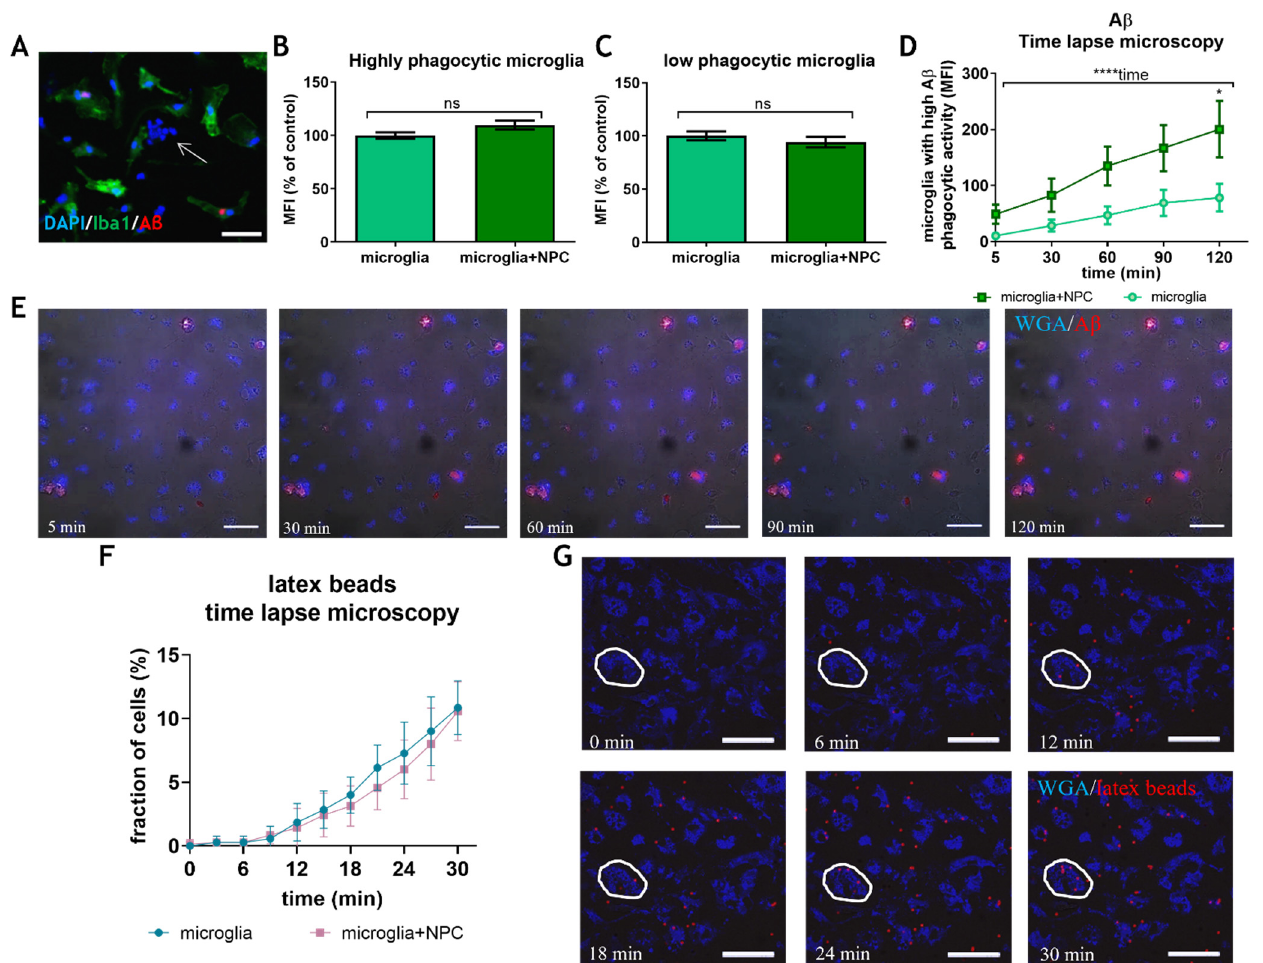
Figure 3. Time-lapse microscopy measuring the effect of newborn NPCs on microglial A β and latex beads’ uptake. ( A ) Fluorescent A β was found only in Iba1+ cells. Arrow = a cluster of NPCs. ( B ) Incubation of microglia with NPCs did not affect the amount of intracellular A β uptake at 2 h in microglia with high A β phagocytic activity. ( C ) Incubation of microglia with NPCs did not affect the amount of intracellular A β uptake at 2 h in microglia with low A β phagocytic activity. ( D ) Analysis of A β uptake by time-lapse microscopy was performed at five time points, showed that co-culturing with NPCs induced a significant two-fold increase in the fraction of microglia with high A β phagocytic activity. Two-way ANOVA and post hoc analysis showed a significant factor of time (**** p < 0.0001), and of NPC effect at 2 h (* p = 0.0184). ( E ) Representative images of time-lapse microscopy for A β uptake at the five time points. ( F ) Analysis of latex beads’ uptake by time-lapse microscopy was performed for 30 min and showed that co-culturing with NPCs did not affect the fraction of microglia with ≥ 3 latex beads’ uptake. ( G ) Representative images of time-lapse microscopy for latex beads’ uptake at six time points. The circle defines cell boundaries. Blue = WGA, red = A β /latex beads, ns = non-significant, MFI = mean fluorescent intensity, scale = 50 µ